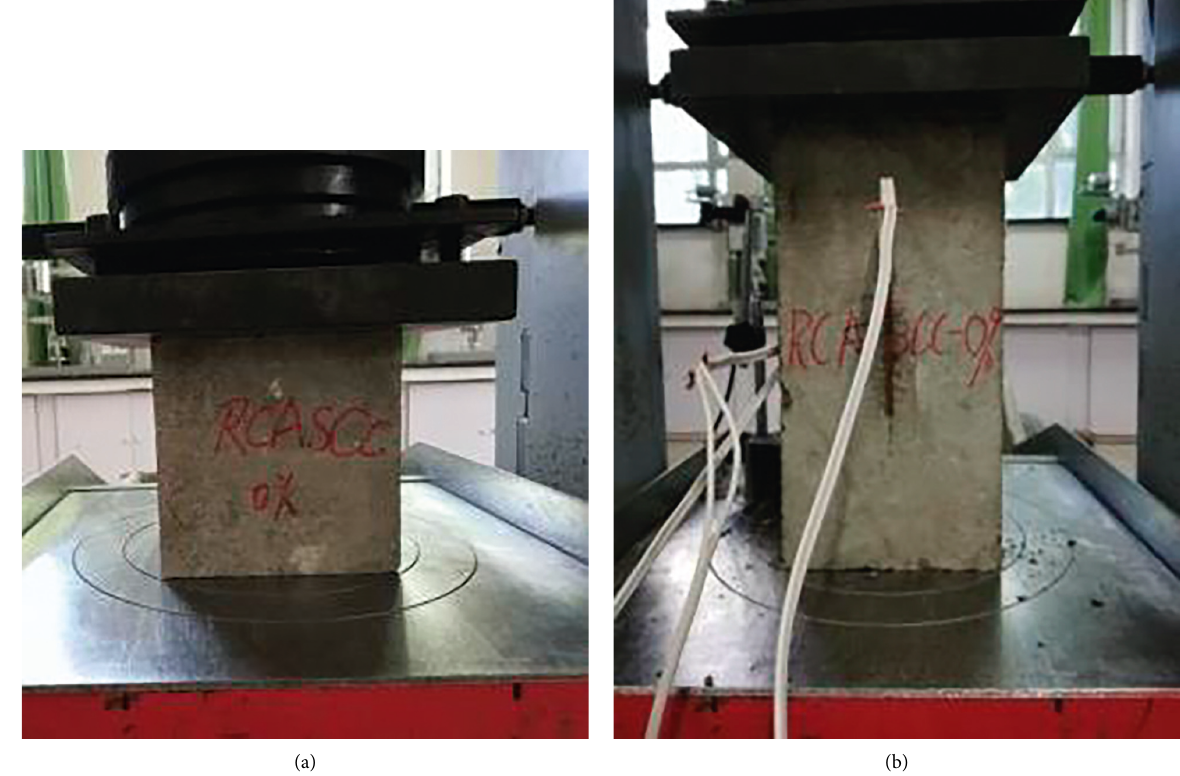
Figure 7: Process of compression tests. (a) Cube compression test. (b) Prism compression